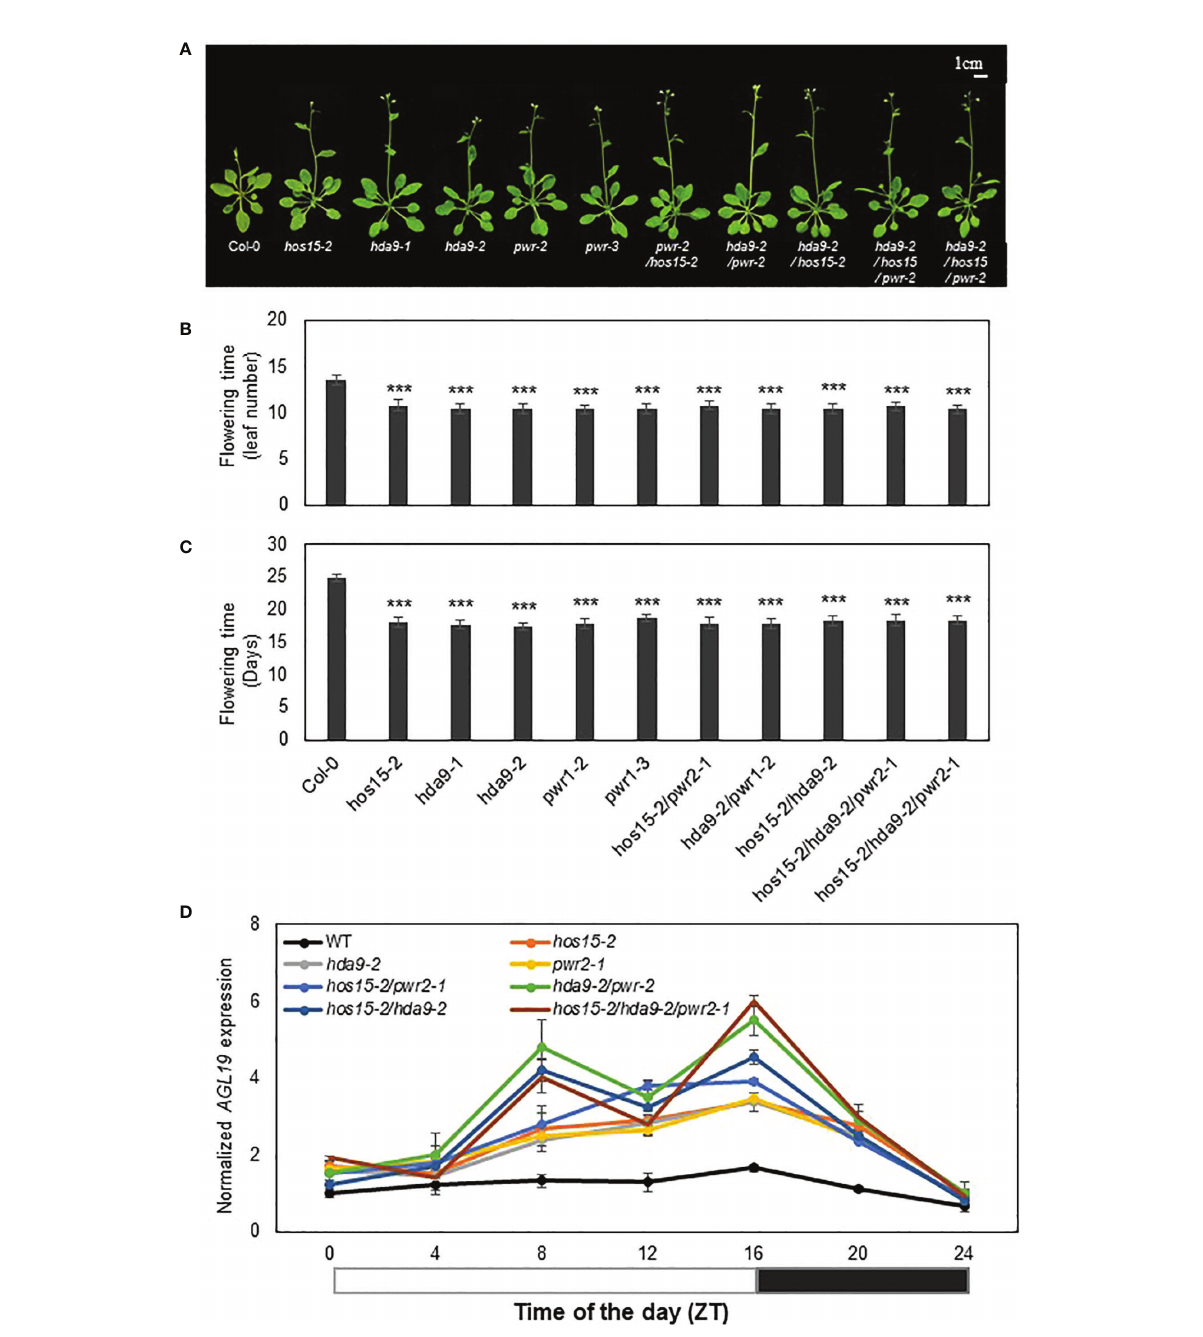
FIGURE 1 Involvement of HOS15, HDA9, and PWR in the same fl owering pathway. (A – C) Flowering time of wild type (Col-0), hos15-2 , hda9 , pwr-2 , as well as double and triple mutant plants under long-day conditions (16 h light/8 h dark). The number of rosette leaves at bolting (B) and days to fl owering (C) were counted from (A) . Data represent means ± SD (n = 19). Signi fi cant difference was determined by a Student ’ s t-test (***p<0.001). (D) The transcript level of AGL19 in two-week-old Col-0, hos15-2 , hda9 , pwr , as well as double and triple mutant Arabidopsis plants. Samples were harvested according to Zeitgeber time (ZT) and were analyzed by RT-qPCR and normalized with ACTIN2. Data represent means ± SD from three biological replicates with three technical repeats each (n = 3). The black and white bar represents night and daylight periods,